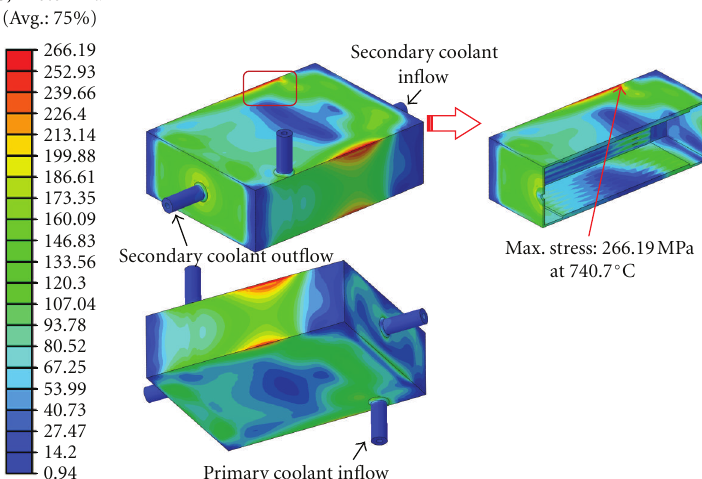
Primary coolant in Figure 13: Overall stress contours of a 3kW class PHE prototype from an elastic-plastic analysis using the weld material